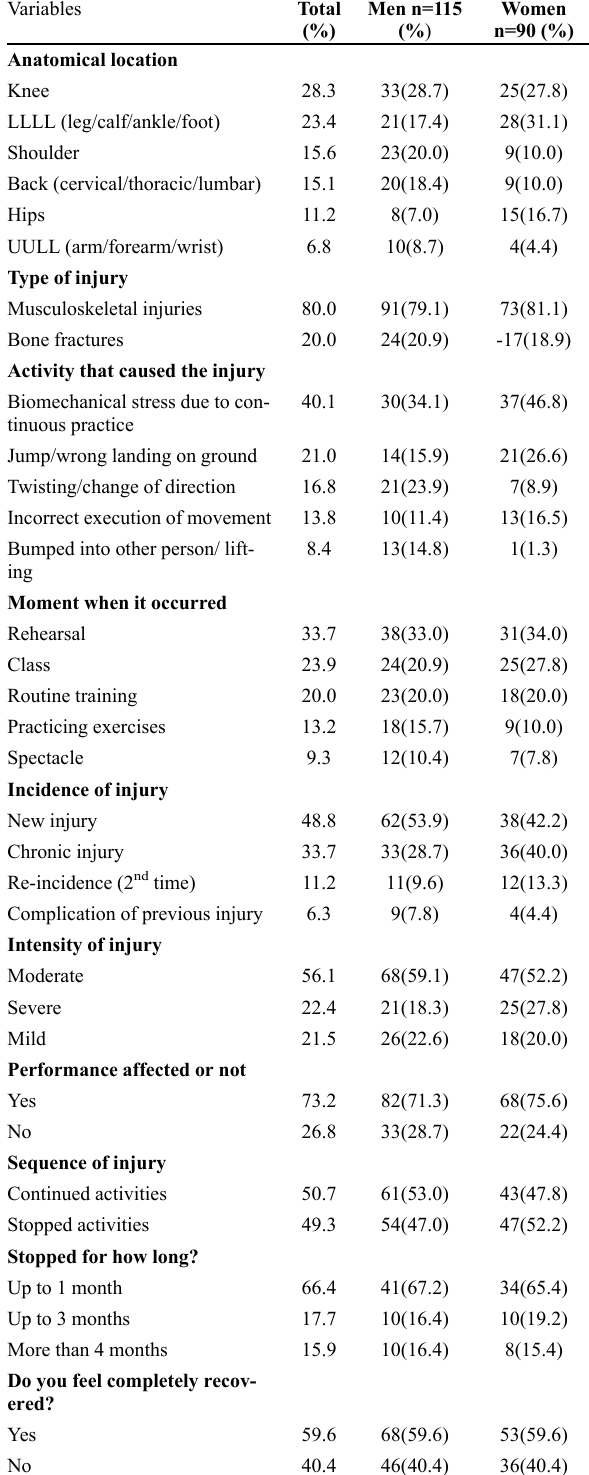
Table 1 - Characterization of the injuries to professional ballroom dan- cers according to sex - Brazil, 2015-2016 (n = 205).